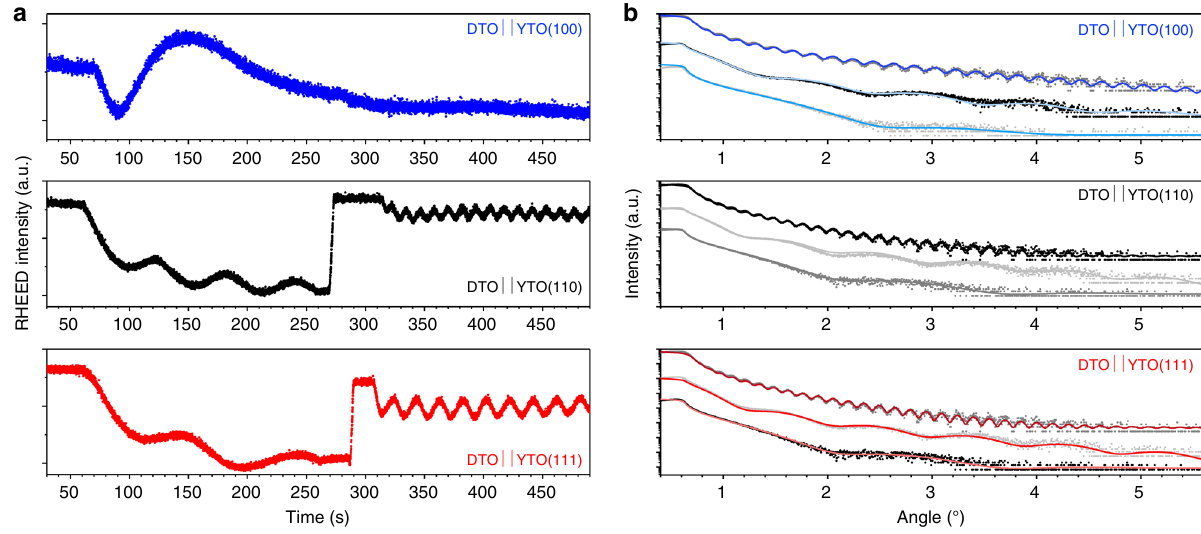
Fig. 1 Layer-by-Layer growth and thickness control. Colour code: DTO||YTO( hkl ) with ( hkl ) = (100) (blue), ( hkl ) = (110) (black), ( hkl ) = (111) (red). a Re fl ection high-energy electron diffraction (RHEED) oscillations measured at the specular spot during deposition. Three different growths are shown, along different crystallographic orientation. Two repetition rates were used during each deposition (initial 200 pulses at 1 Hz to help nucleation, increased to 5 Hz afterwards), hence the two oscillation periods. For samples DTO||YTO(110) and DTO||YTO(111), one oscillation corresponds to ¼ of the cell, equivalent to the formation of one tetrahedron of Dy ions (one unit cell along these orientations contains four corner shared tetrahedra of Dy ions). In the case of DTO||YTO(100) only one oscillation is detected, compatible with the formation of 1 unit cell (along this orientation growth, there is no stacking of corner shared tetrahedra of Dy ions). b Re fl ectivity measurements for all the x DTO||YTO( hkl ) samples and related fi ts (values are reported in Table 1). In these re fl ectivity plots, each scan (samples with same hkl orientation, but different number of monolayers x ) has been displaced vertically to improve clarity. DTO Dy 2 Ti 2 O 7 , YTO Y 2 Ti 2 O